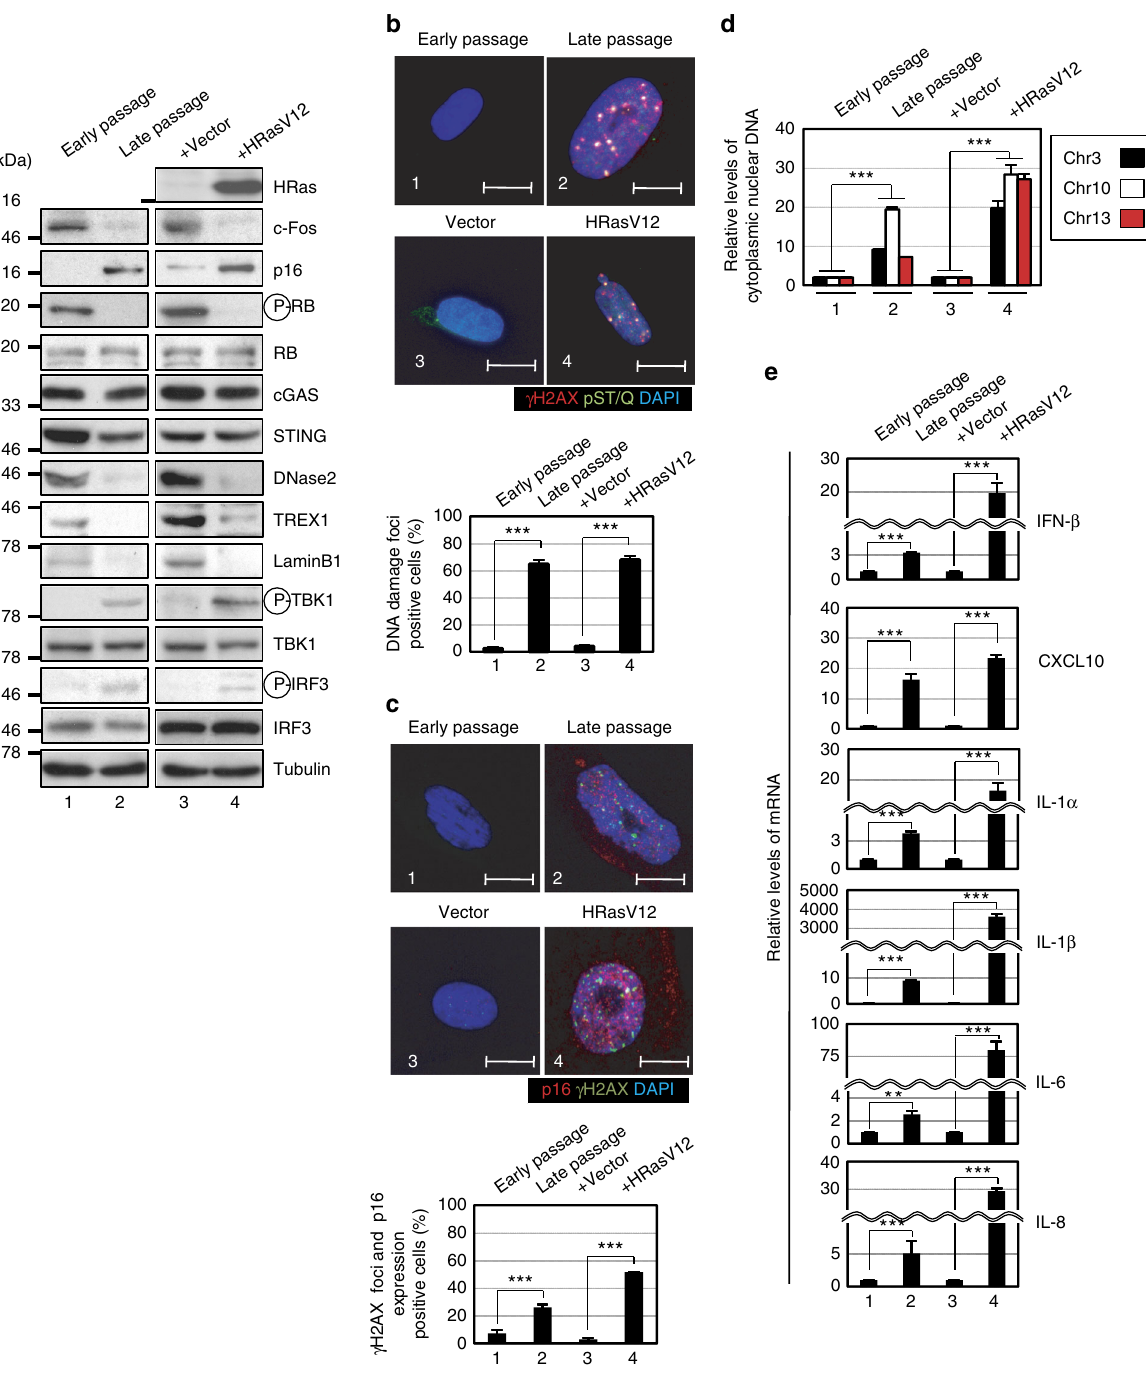
Fig. 1 Activation of cytoplasmic DNA sensing machineries in senescent cells. a – e Pre-senescent TIG-3 cells were rendered senescent by either serial passage (late passage) or ectopic expression of oncogenic ras ( + HRasV12). These cells were then subjected to western blotting using antibodies shown right ( a ), immuno fl uorescence staining for markers of DNA damage ( γ -H2AX [red], phosphor-Ser/Thr ATM/ATR (pST/Q) substrate [green] and 40,6- diamidino-2-phenylindole [blue]) ( b ) and p16 expression and γ -H2AX foci formation (p16[red], γ -H2AX [green] and 40,6-diamidino-2-phenylindole [blue]) ( c ), qPCR analysis of chromosomal DNA in cytoplasmic fraction ( d ) or RT-qPCR analysis of SASP factor gene expression ( e ). Tubulin was used as a loading control ( a ). For all graphs, error bars indicate mean ± standard deviation (s.d.) of triplicate measurements. ** P < 0.01. *** P < 0.001. Scale bars, 10 μ m ( b and c